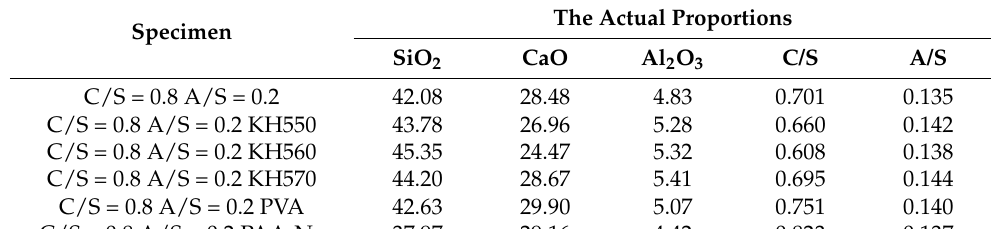
Table 5. Oxide composition of each powder formulation as determined by X-ray fluorescence analysis. An error of approximately 1 wt% is expected.